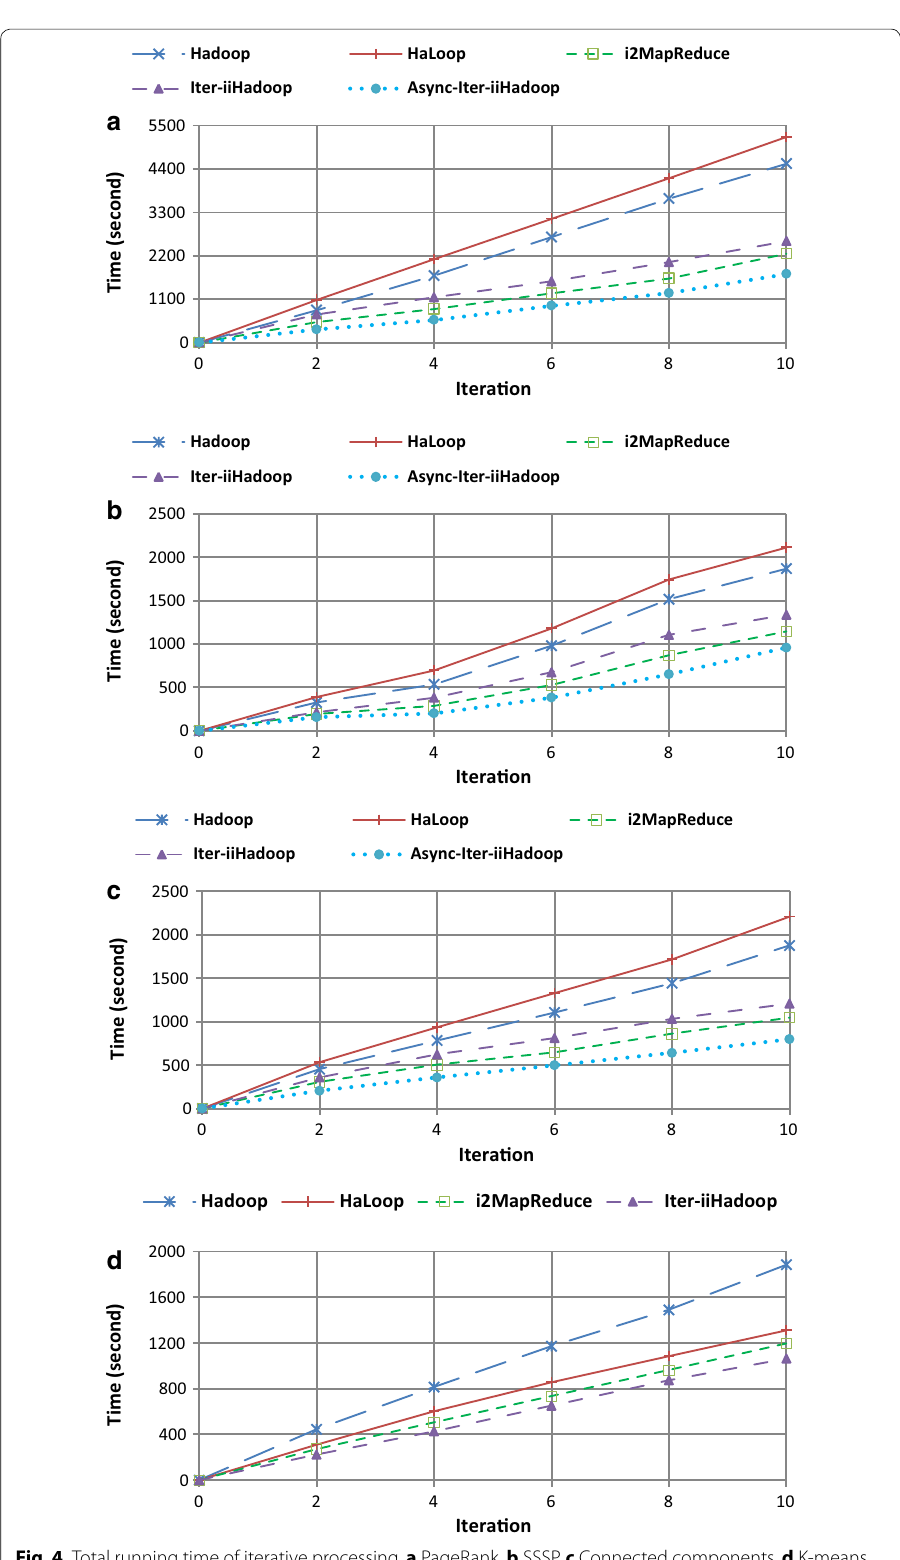
Fig. 4 Total running time of iterative processing. a PageRank. b SSSP. c Connected components. d